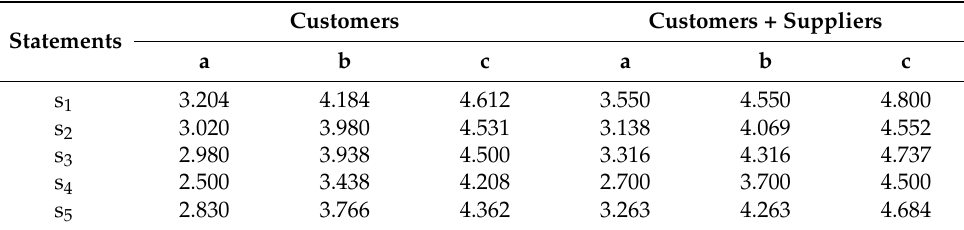
Table 3. Average ratings of the statements presented by the enterprise representatives in the form of triangular fuzzy numbers (a group of customers vs. a group of customers and suppliers jointly).